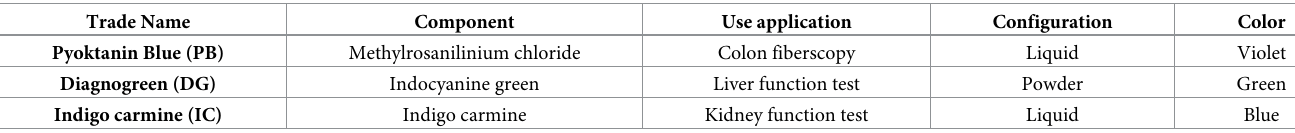
Table 1. Characteristics of dye solutions used in the